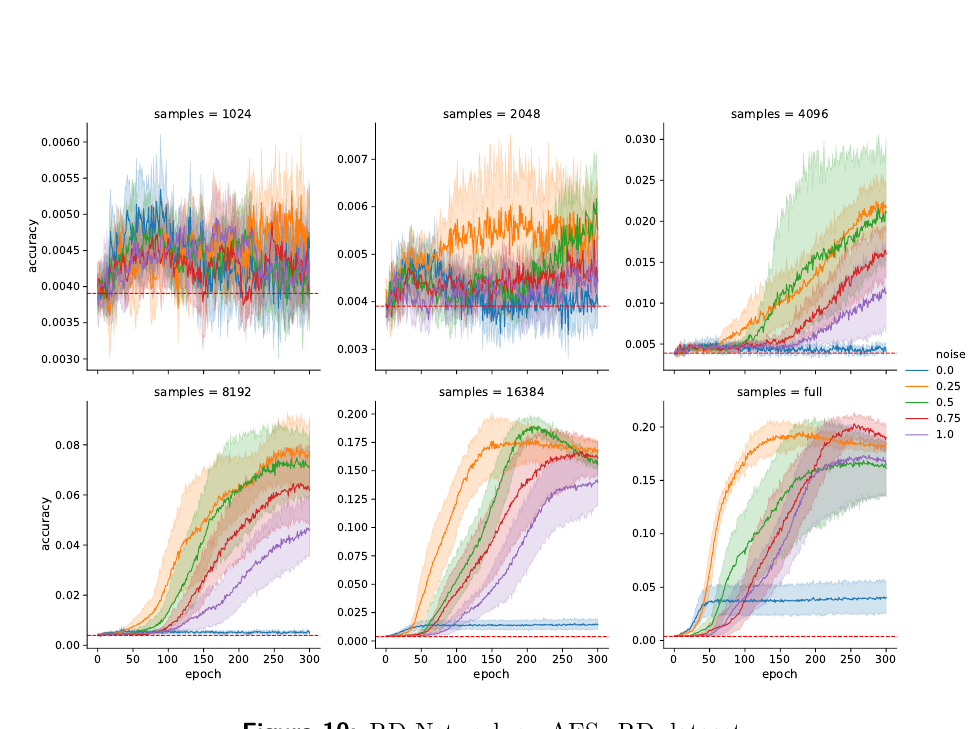
Figure 10: RD Network on AES_RD dataset